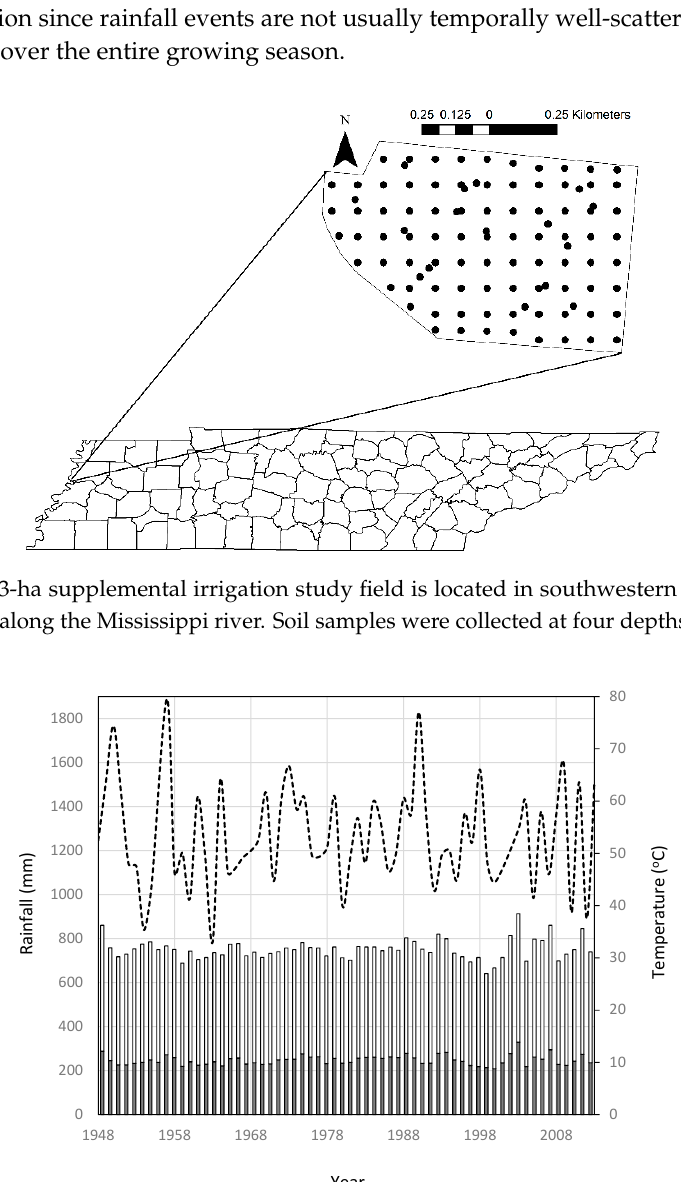
Figure 2. The long-term climatic variation in rainfall (dashed line) and temperature (column) in west Tennessee. Temperature columns show the mean monthly minimum (in black) and the mean monthly maximum (in white).